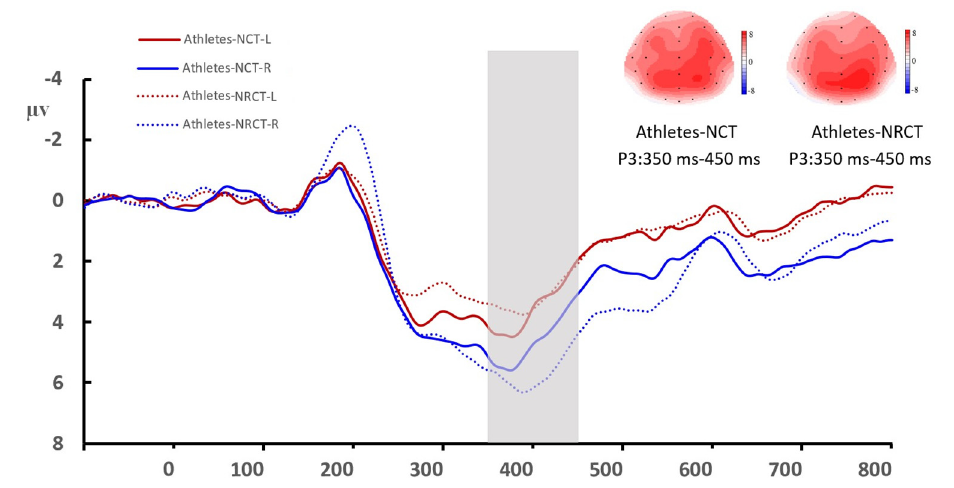
Figure 5. Mean amplitude of the P3 component in the two hemispheres among table tennis athletes. Averaged data of the left hemisphere are from the F3, F7, FT3, FT7, CP3, and P3 electrodes. Averaged data of the right hemisphere are from the F4, F8, FT4, FT8, CP4, and P4 electrodes. The topographies correspond to average activity in the time windows of 350–450 ms (indicated by the gray bar) around the local peaks. NCT: notch circle task; RNCT: rotating-notch circle task.